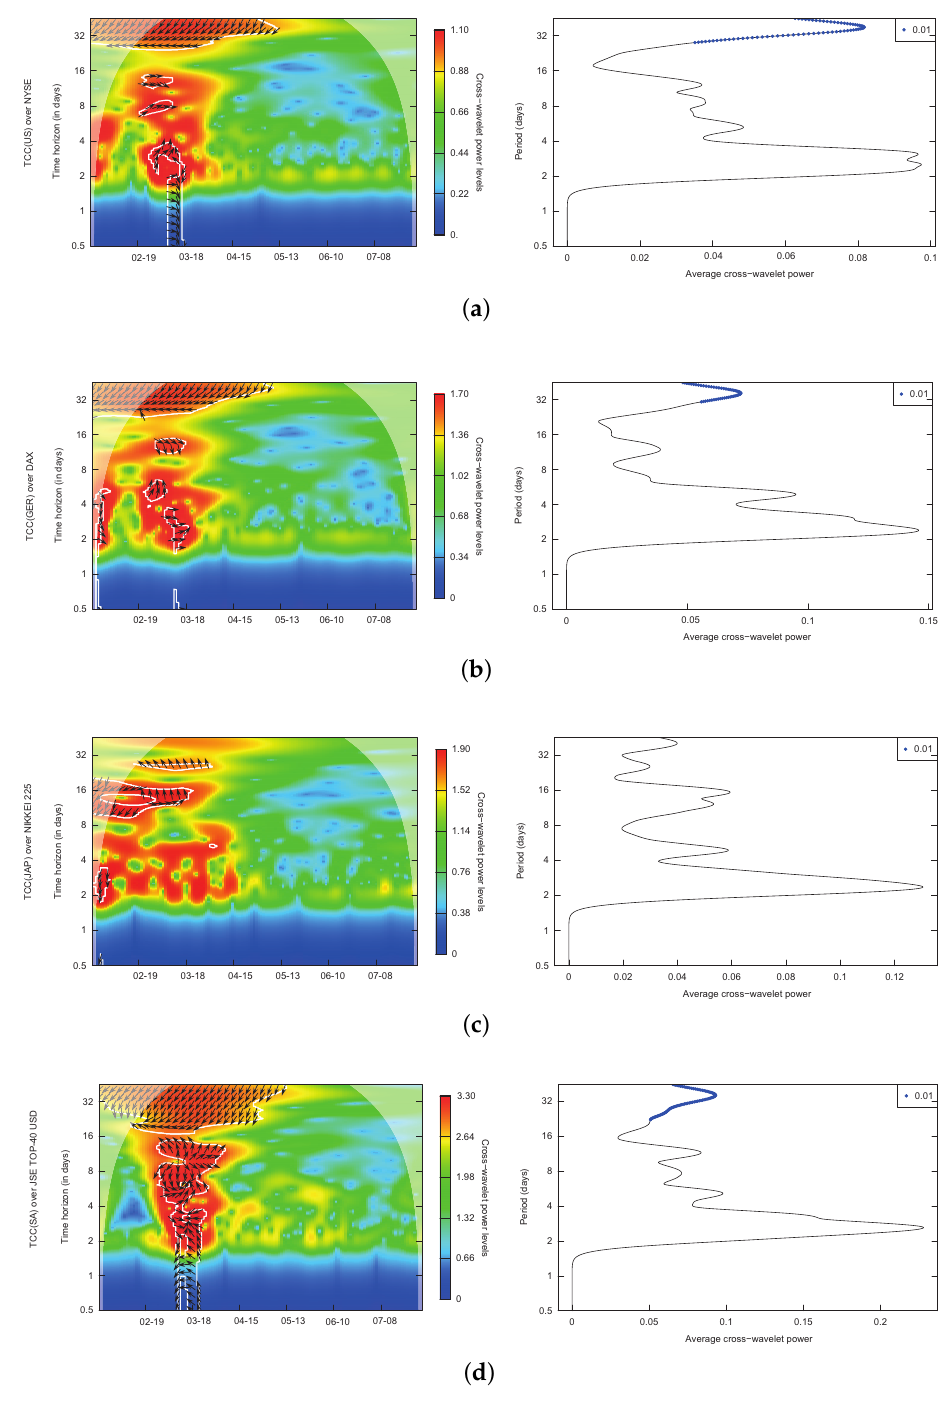
(Figure 6a), Germany (DAX over TCC(GER) (Figure 6b), Japan (NIKKEI 225 over TCC(JAP) (Figure 6c), South Africa (JSE TOP-40 USD over TCC(SA) (Figure 6d), Australia (ASX 200 over TCC(AUS) (Figure 6e), and Brazil (IBOVESPA over TCC(BRA) (Figure 6f). Note the splitting of Figure 6 into consecutive subfigures to facilitate the visualization of the possible presence of comovements between the pairs of